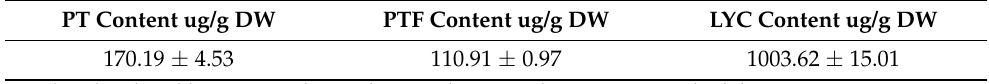
Table A2. UPLC – MS/MS performance of 5-HMF.